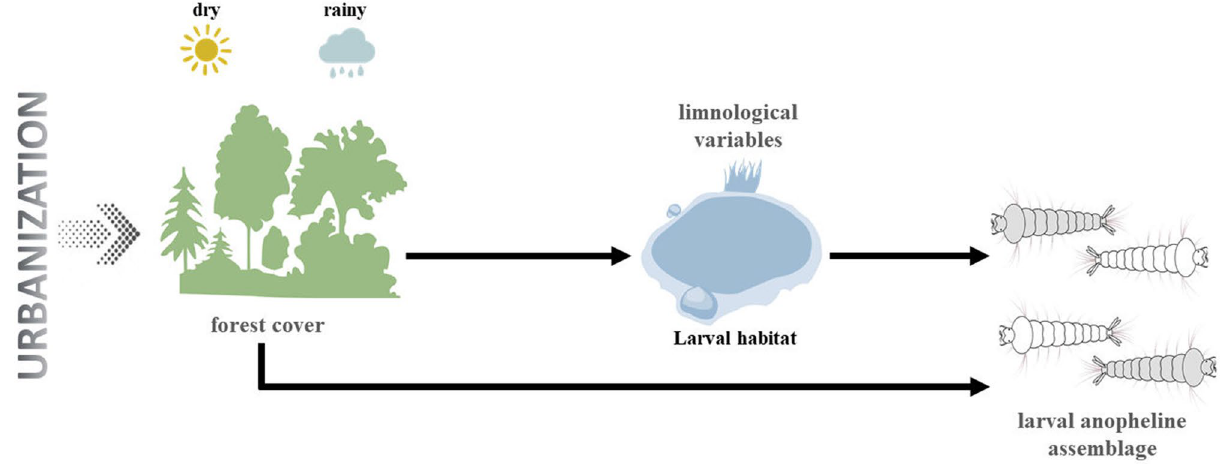
Figure 1. Conceptual structural equation model. The image was created using Abode Illustrator 2020 (https:// www. adobe. com/ br/ produ cts/ illus larvae and adults. For example, forest loss can reduce anophelines in the subgenus Kerteszia , which depend on tree holes and bromeliads for larval habitats 16 . The loss of native vegetation can also change microclimatic condi-